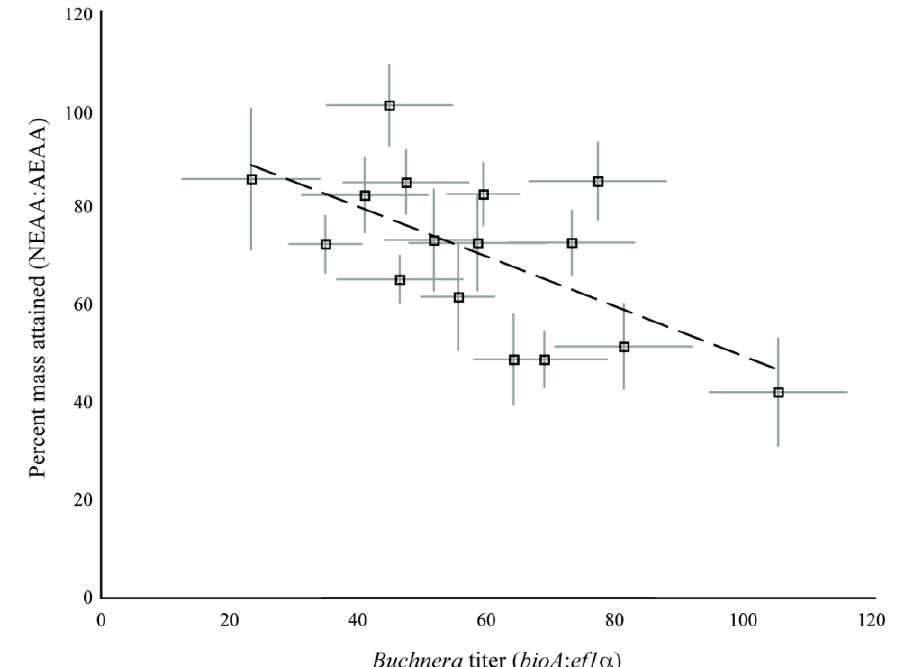
Figure S2. Correlation of Buchnera titer and amino acid requirements for all clones. Each point represents the mean of a clone, error bars are +/- SE. The relationship was significant, R 2 = 0.38, F1,14 = 8.71, p = 0.01,